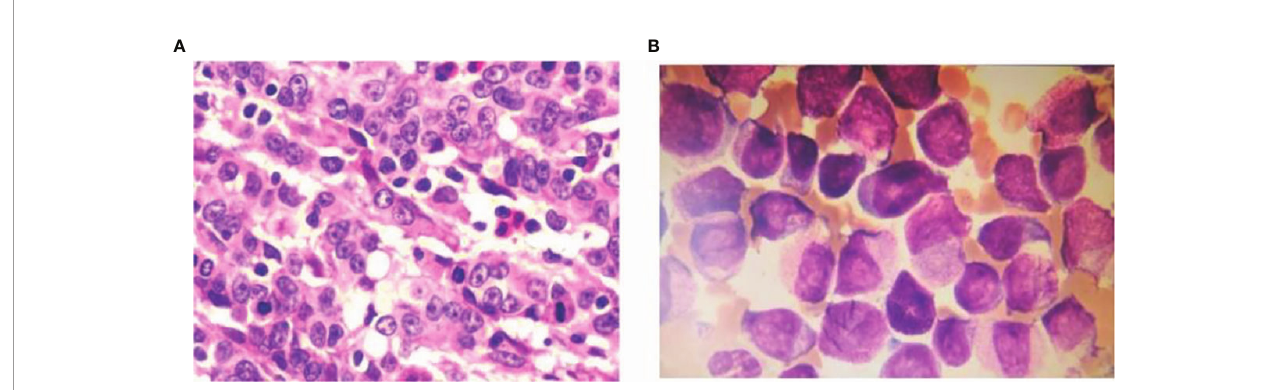
FIGURE 2 | Ulcerated hypofractionated adenocarcinoma of the lesser curvature of the gastric body HE staining 10×40 (A) Examination (170259) shows: ulcerated hypofractionated adenocarcinoma of the lesser curvature of the gastric body, Lauren ’ s staging: diffuse; tumor size 4.5×3 cm. Cancerous tissue in fi ltrated the plasma layer to the extra-plasma fatty tissue, nerve invasion; cancerous thrombus formation in the lymphatic vessels, no clear cancerous thrombus in the blood vessels; no cancerous tissue was seen in the upper and lower cut edges of the specimen and another sent for examination. No cancerous tissue was seen in the cut margins, the greater omentum (-), regional lymph nodes (0/44) were seen to be metastatic, including (group 1) lymph nodes (0/7), (group 2) lymph nodes (0/4), (group 3) lymph nodes (0/3), (group 4) lymph nodes (0/4), (group 5) lymph nodes (0/0), (group 6) lymph nodes (0/3), (group 7) lymph nodes (0/5), (group 8a) lymph nodes (0/5), (group 9) lymph nodes (0/3), (group 11)